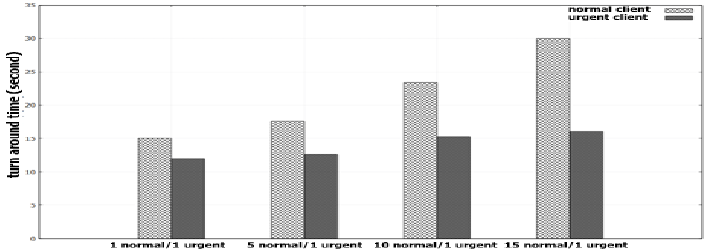
Figure 9. SLA analysis: our proposed adaptive scheme can satisfy the SLA requirement of a urgent client even when the number of normal clients increases.